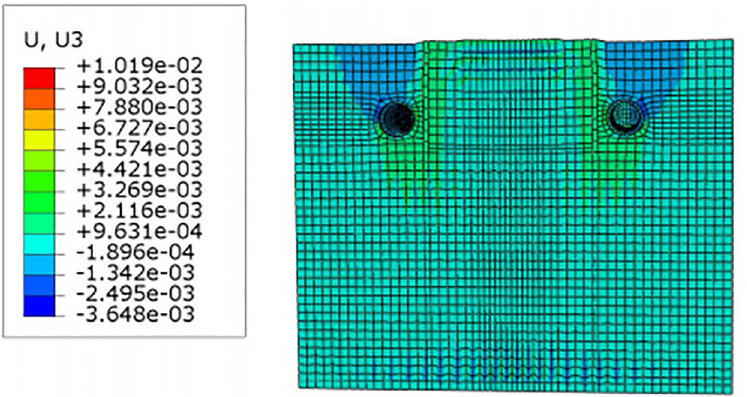
Fig 13. Model deformation of loess-like soils in the x-direction.